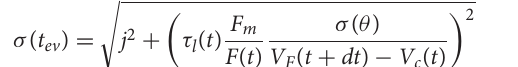
200 µ s and τ l 500 µ s = =